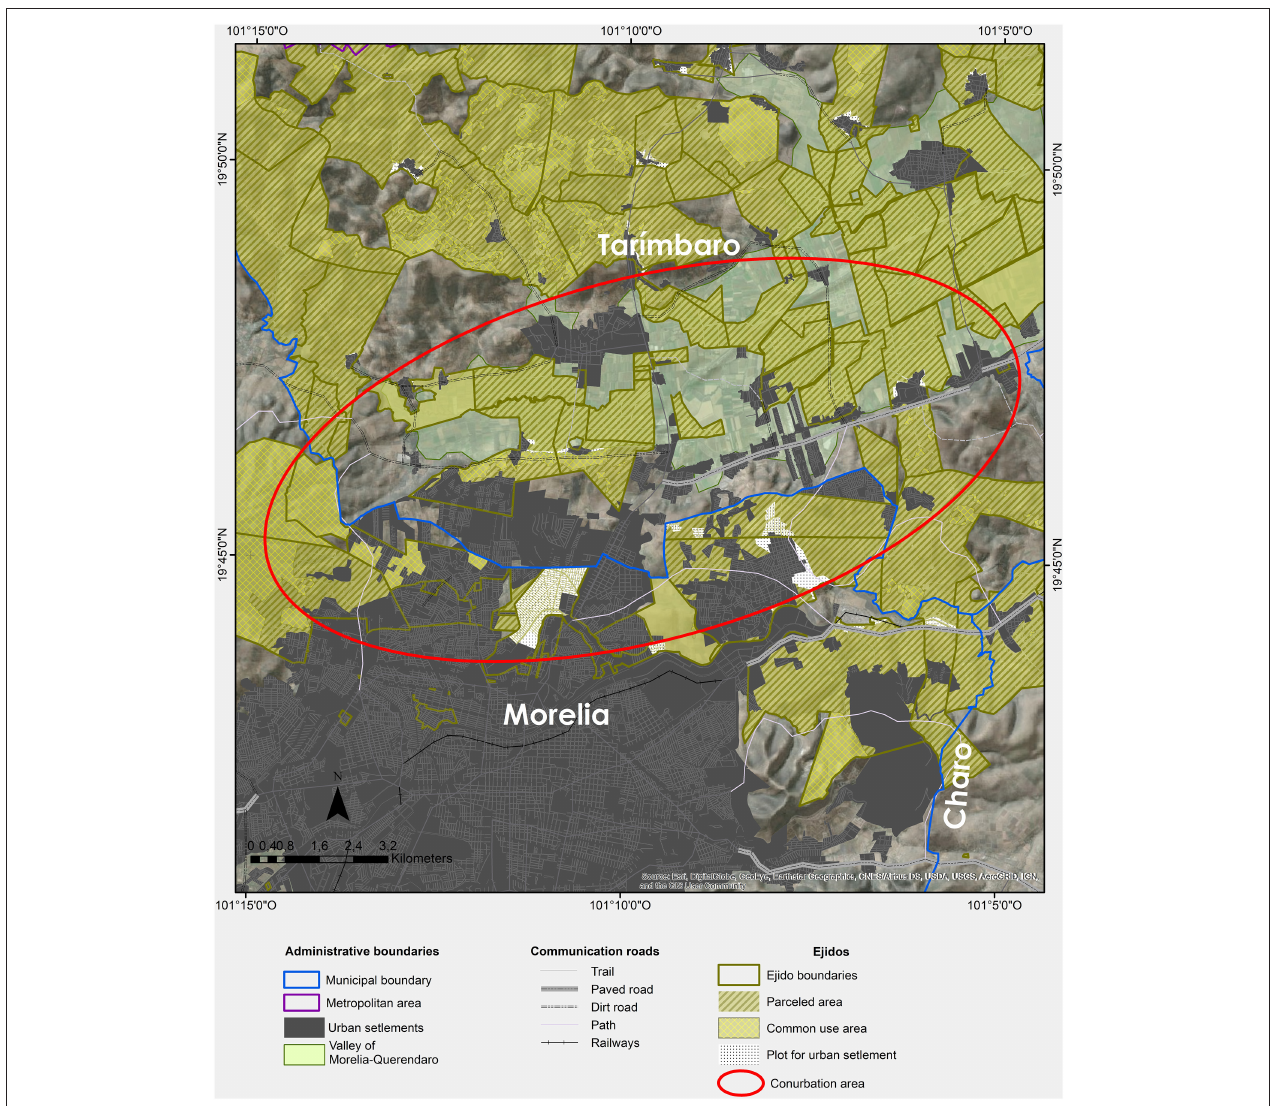
FIGURE 2 | Morelia-Tarímbaro